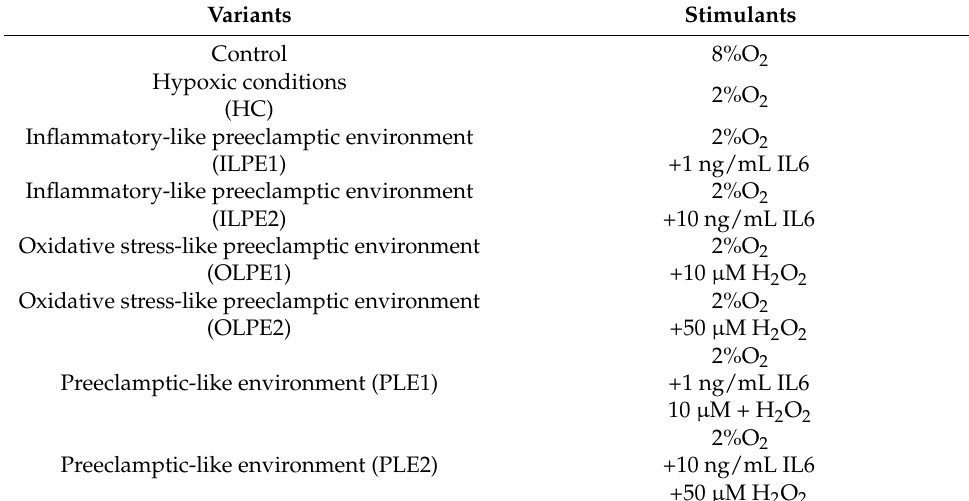
Table 1. The stimulants and variants of the stimulation used in the study. The second variant refers to the different concentrations of the used